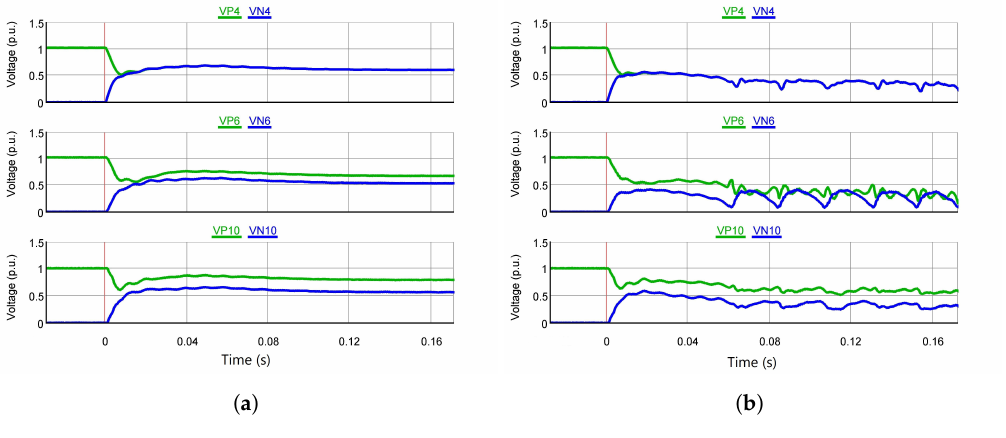
Figure 8. Sequence voltages from RTDS simulations subject to an A–B fault at bus 4: ( a ) a stable scenario. ( b ) an unstable scenario. (VP: positive-sequence voltage; VN: negative-sequence voltage; the number refers to the bus